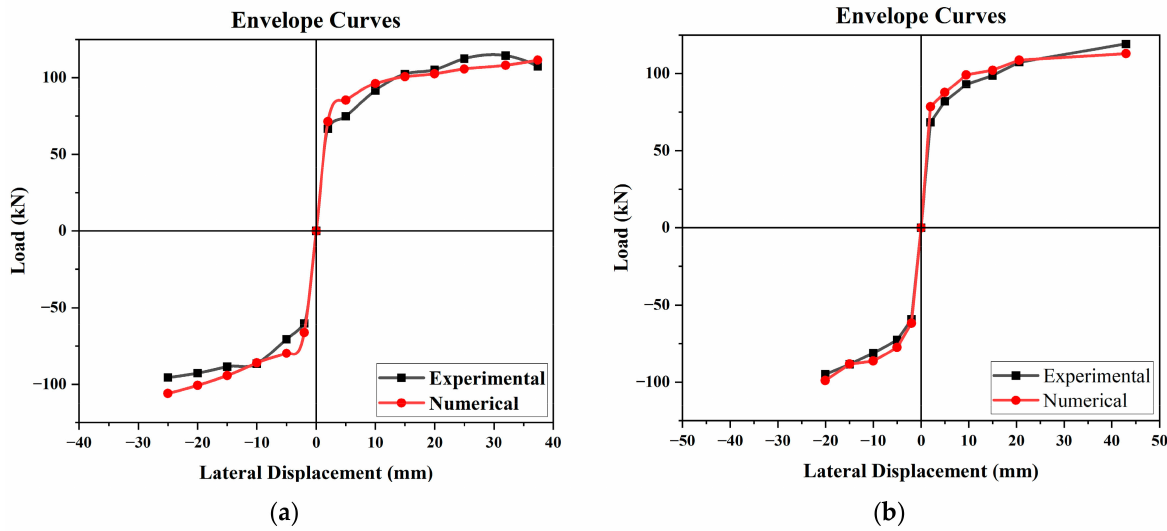
Figure 16. Comparison of experimental and numerical results ( a ) OPC-CM ( b )